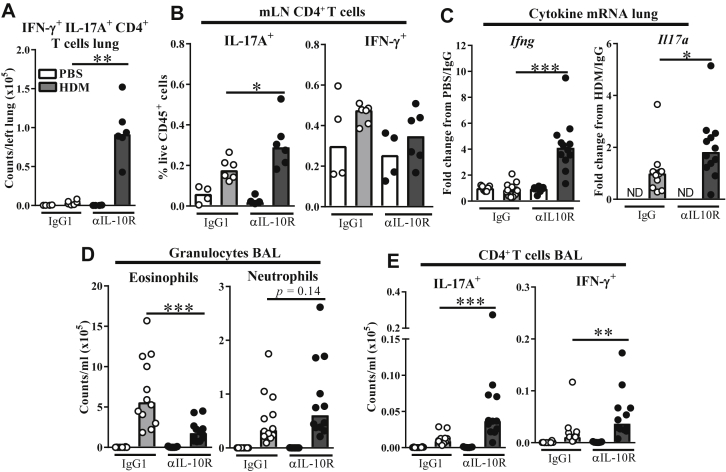
Additional effects of local IL-10R blockade on the immune response to HDM. A and B, Flow cytometric data. Fig E4, A, Numbers of IL-17A/IFN-γ double-positive CD4+ T cells in lung tissue. Fig E4, B, IL-17A+ and IFN-γ CD4+ T cells as percentages of total CD45+ leukocytes in mLNs. C, Fold changes (from the indicated group) of Ifng and Il17a mRNA expression in homogenized lung tissue. D and E, Flow cytometric data showing numbers of eosinophils, neutrophils, and IL-17A+ and IFN-γ CD4+ T cells in BAL fluid. Data in Fig E4, A and B, are from 1 of 2 experiments showing comparable results (n = 3-6 per group). Other data are pooled from 2 experiments (n = 7-12 per group). Data are shown as medians and individual replicates. *P < .05, **P < .01, and ***P < .001. ND, Not detected.